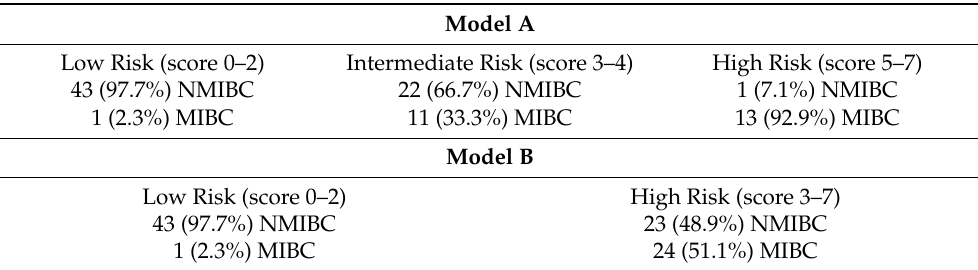
Table 5. Molecular risk models A and B presented as NMIBC and MIBC clinical categories (See also Figure